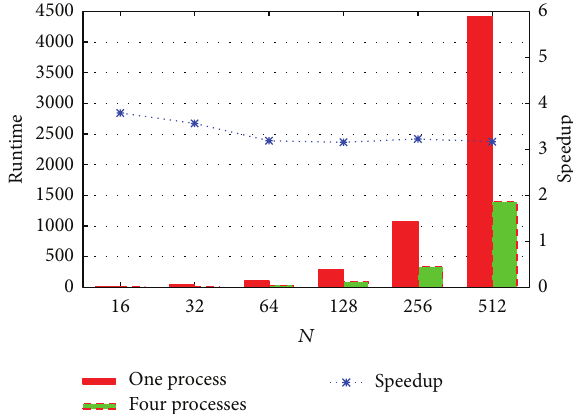
Figure 8: Performance comparison between one process and four processes on E5540 with fixed 𝑀 .